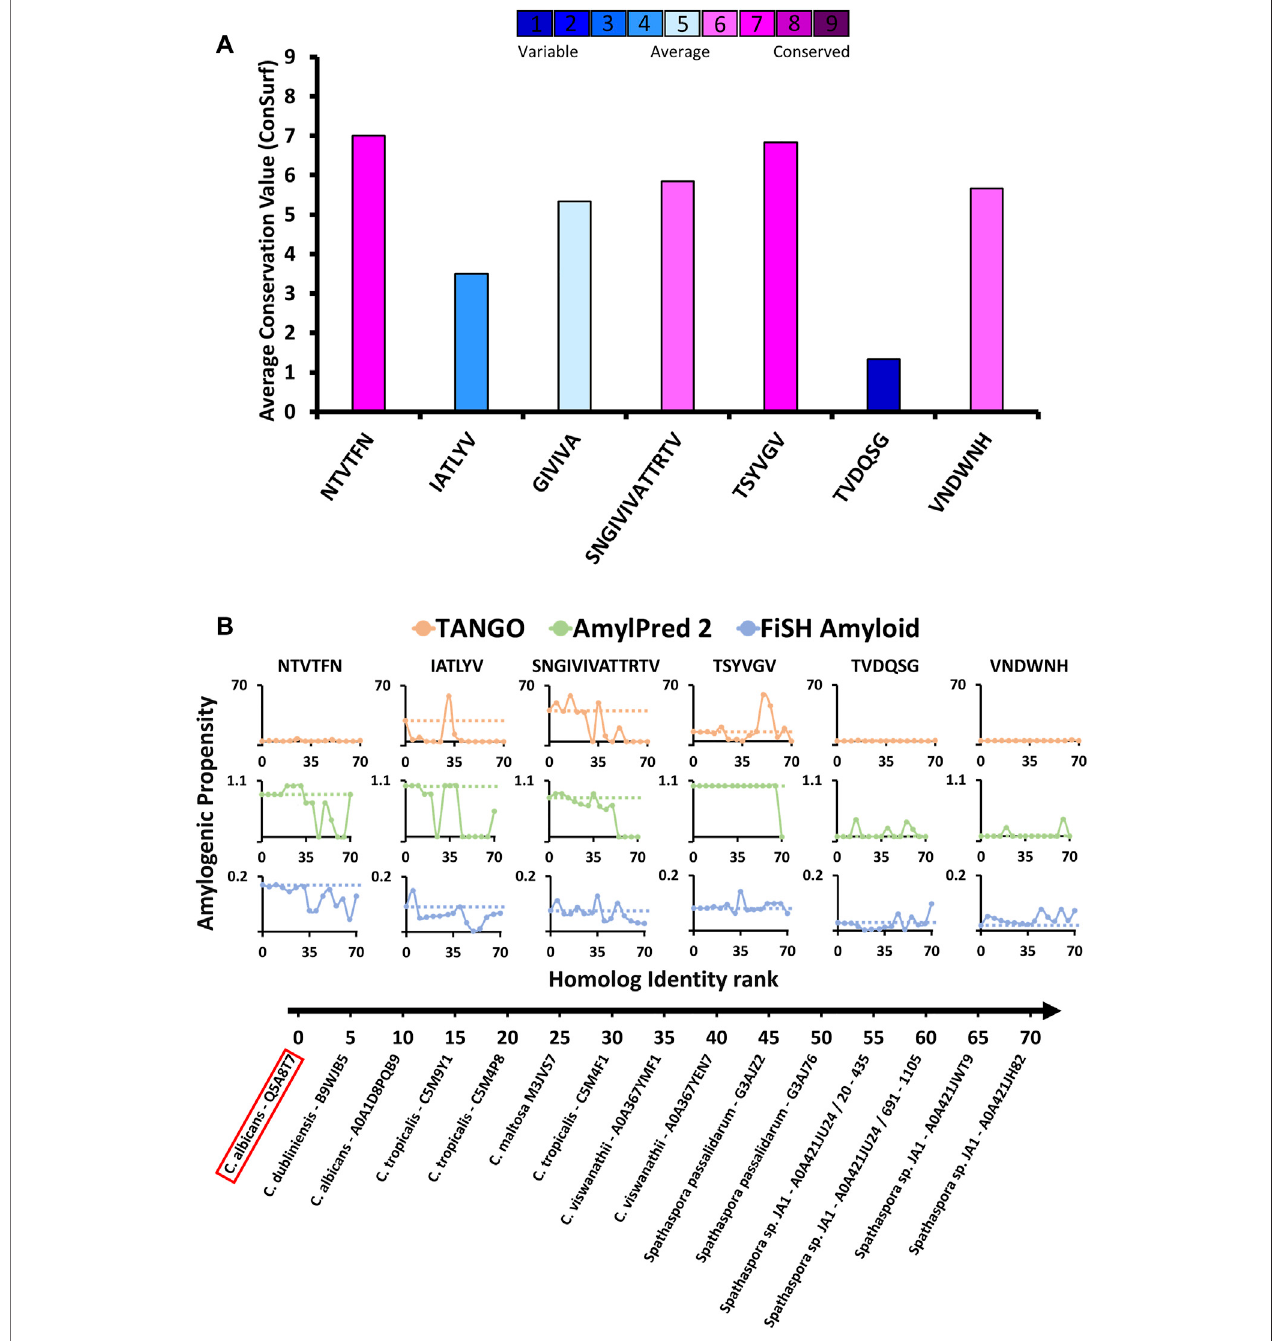
FIGURE4| Amyloidogenicpropensityandtheevolutionaryconservationof C.albicans Als5segments. (A) EvolutionaryconservationofAls5segments.Thegraph displays evolutionary conservation values for seven segments (three segments with resolved crystal structures, known amyloid spine 322 SNGIVIVATTRTV 334 , and two control segments) from C. albicans Als5. These values were calculated based on a multiple sequence alignment of 71 homologs of Als5 generated using the ConSurf webserver (Berezin et al., 2004; Landau et al., 2005; Ashkenazy et al., 2016). The columns ’ colors correspond to the average evolutionary conservation score (1 beingtheleastconservedand9beingthemostconserved). (B) TheamyloidogenicpropensitiesoftheabovesevensegmentsinAls5orthologs(homologsfromdifferent species). Fourteen representative orthologs of Als5p were selected to represent a diverse group (as described in the Method section). The orthologs are plotted on the X -axis by their sequence similarity to C. albicans (evaluated based on ConSurf e -value parameter) from most to least similar homolog. The Y -axis shows the average amyloidogenicpropensity ofeach segmentinthefourteenorthologs. Theamyloidogenicvalueswerecalculatedusingthreeservers anddisplayed usingdifferentcolors: TANGO(orange)(Fernandez-Escamillaetal.,2004),AmylPred2(green)(Tsolisetal.,2013),FiSHAmyloid(blue)(GasiorandKotulska,2014).Thedifferentmethodshave a different score range, thus in each graph, a horizontal dashed line indicates the amyloidogenic value of the relevant segment from C. albicans Als5.